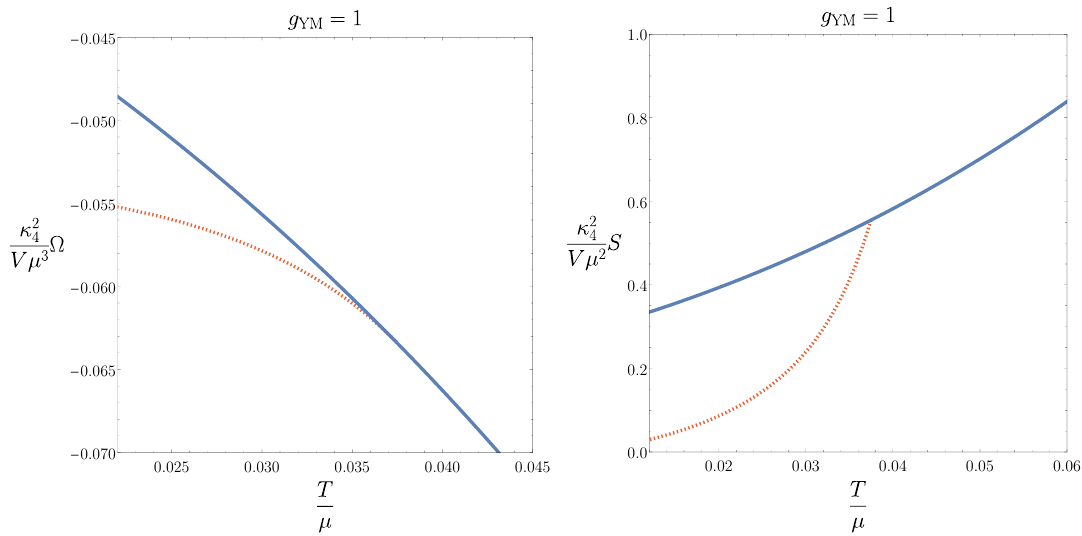
Figure 6. The grand potential Ω as a function Figure 7. The entropy S as a function of of temperature for both normal and condensed temperature for both normal (blue) and con- phase with g YM = 1 . The red dashed curve (con- densed (red, dashed) phase with g YM = 1 . At densed phase, h J x i 6 = 0 ) and the blue curve (nor- T = T c , the red curve is continuous but non- 1 mal phase, h J x i = 0 ) smoothly intersect showing differentiable. The behaviour exhibited is there- 1 that Ω is both continuous and differentiable. fore that of second order phase transition.